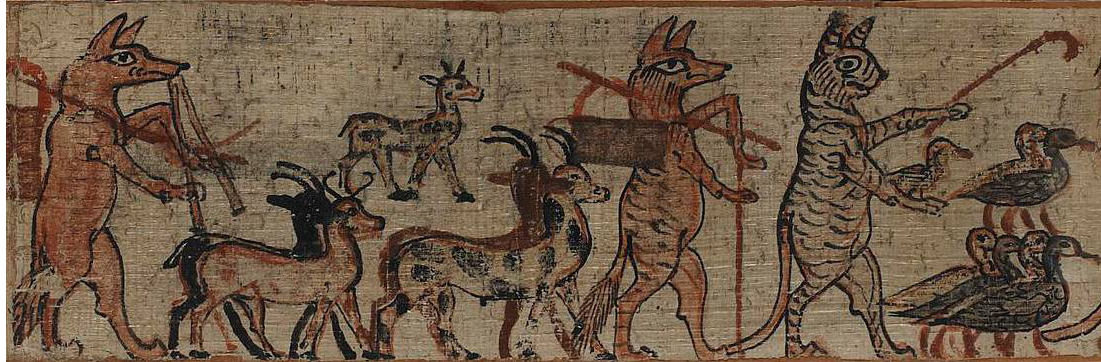
Figure 13. Canines leading caprids (detail of BM reg. no. EA10016), illustrated papyrus, Deir el-Medina, Ramesside period (Image courtesy of the Trustees of the British Museum, London).